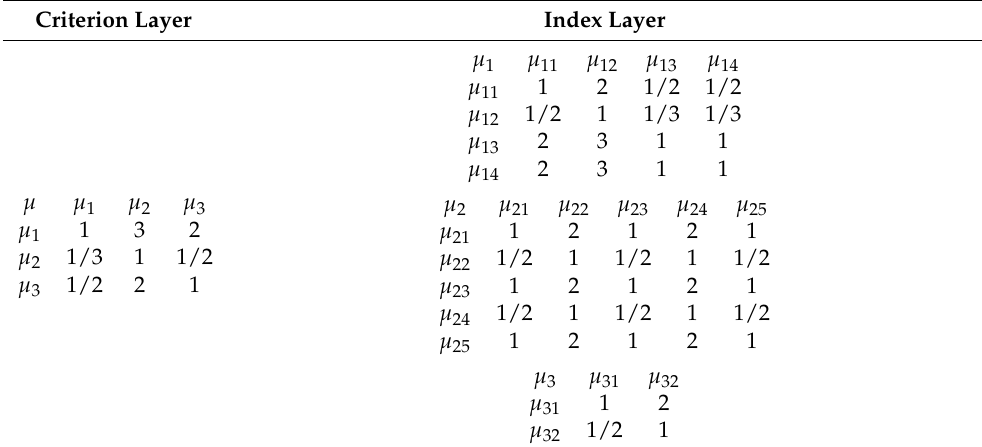
Table 7. The judgement matrix for evaluation of the driving behaviour.